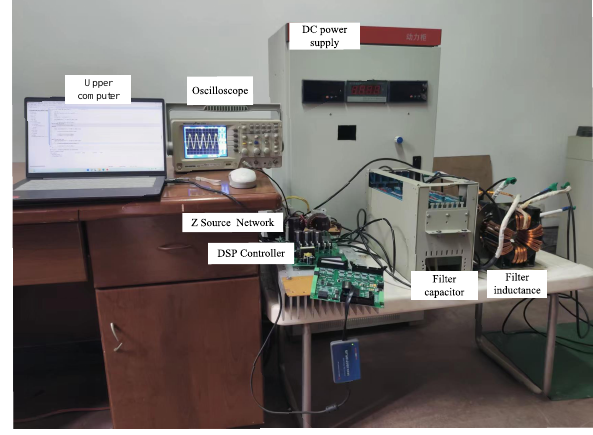
Figure 14. Z-source inverter experimental platform.